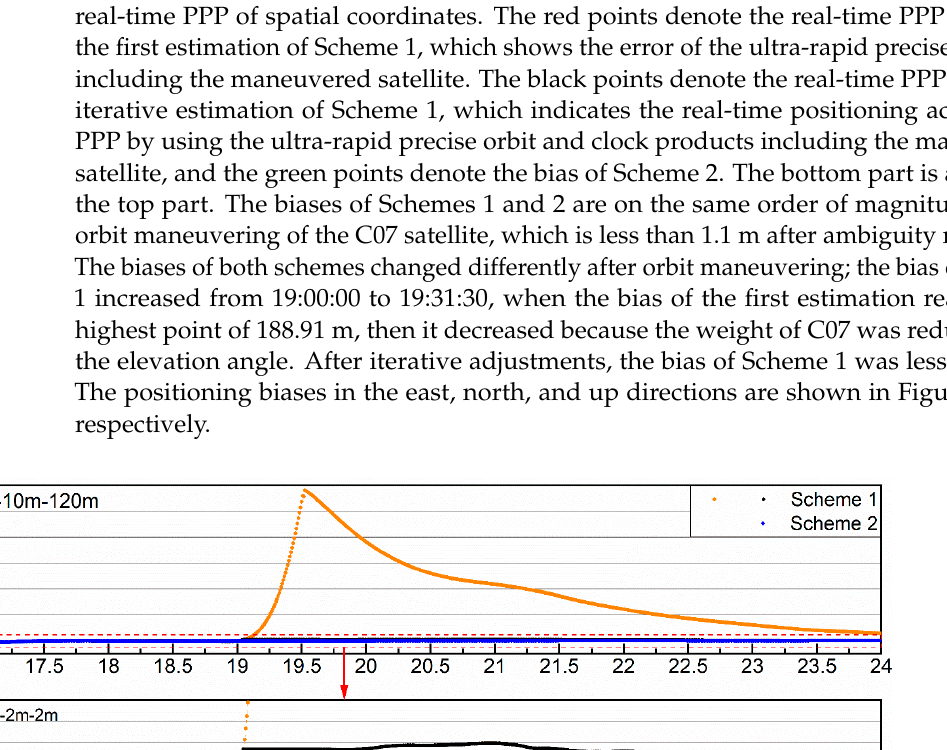
Figure 10. Bias of real-time precise point positioning (PPP) of spatial coordinates.